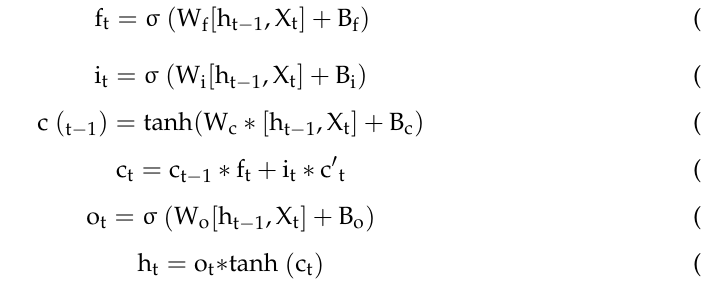
Table 3. Definition and description of the variables used in the LSTM model [32] .